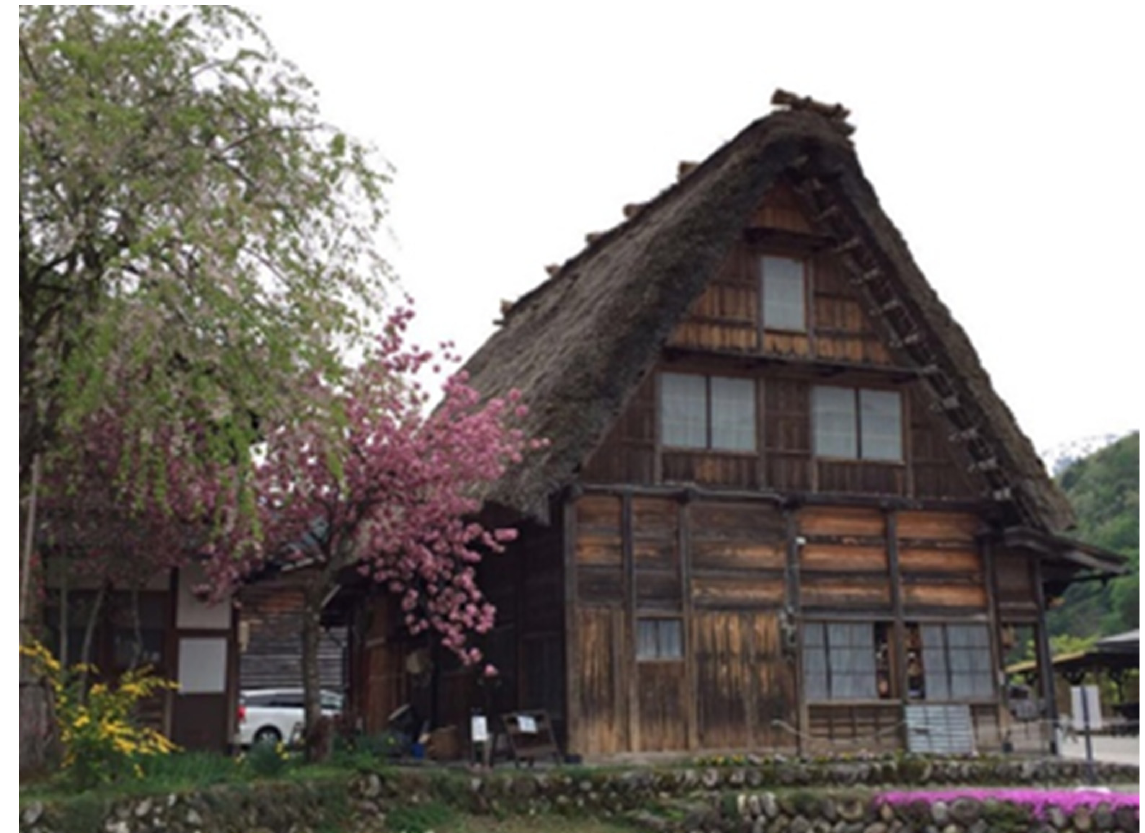
Figure 4. Photograph by Participant E.